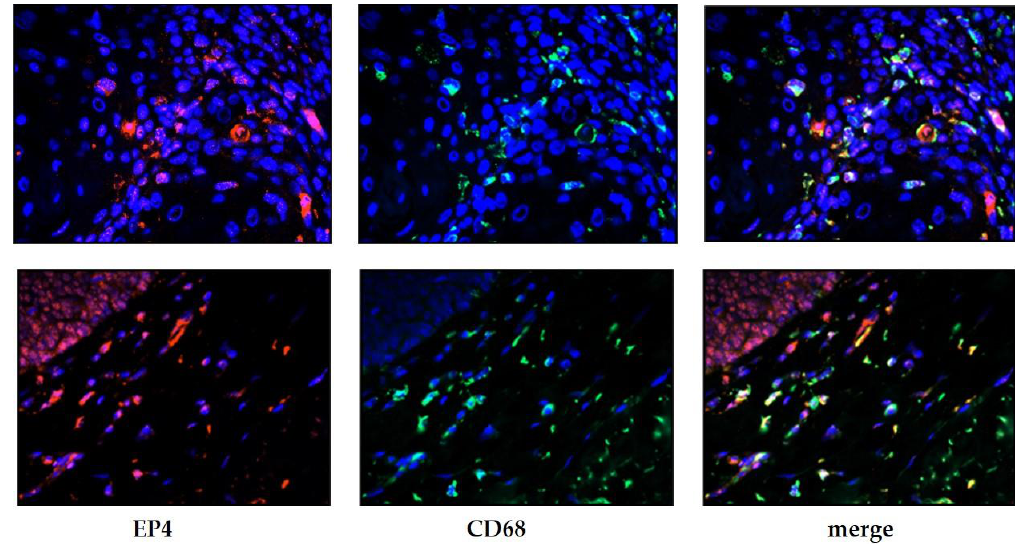
Figure 3. Characterization of immune cells as macrophages using immunofluorescence double staining. Cell nuclei were marked by 4′,6-diamidino-2-phenylindole (DAPI) staining (blue): left column shows EP4-positive cells (red), center column shows CD68-positive cells (green) and right column shows the coexpression of both markers CD68 and EP4.